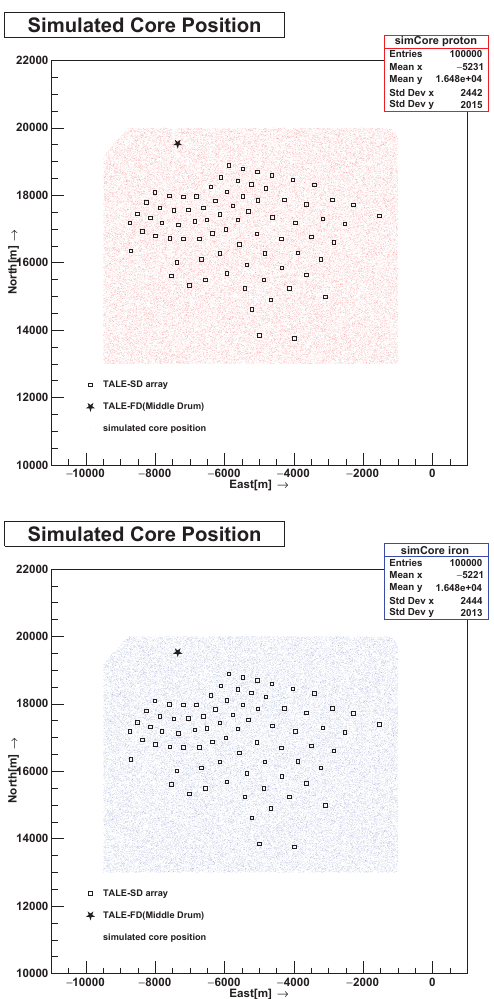
Figure 4: 22 parameters by the TALE-SD array histograms. Pro- ton MC is shown with red lines and iron MC is shown with blue them. "Entries" indicates the number of